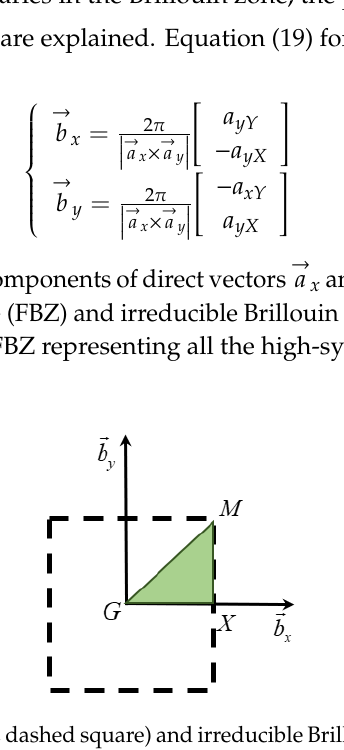
Figure 5. Direct vectors in a periodic model.